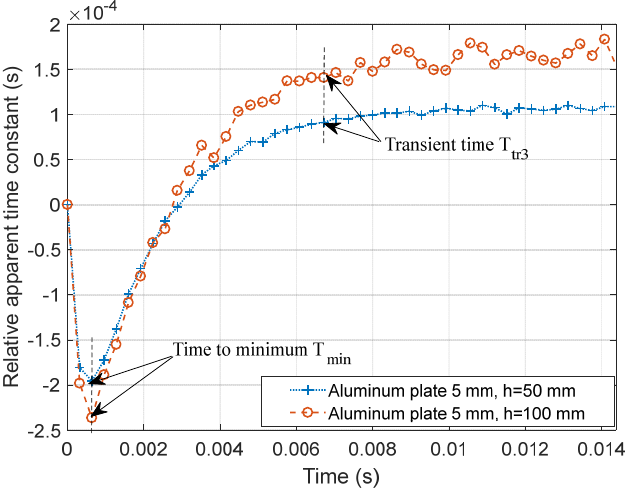
Figure 11. The effect of lift-off variations on the differential D-ATC curve. The increase in lift-off reduces the signal-to-noise ratio of the D-ATC curve but does not change the time characteristics. It can be seen from Figure 11 that the shortening of lift-off improves the signal-to- noise ratio of the D-ATC curve and compresses the amplitude of the differential D-ATC curve. However, lift-off variations did not change the time features (e.g., T min and T tr 3 ) of the differential D-ATC curve, which is consistent with the simulation result in Figure 4b. Therefore, the 𝑇 (cid:3047)(cid:3045) signature of the D-ATC curve is not affected by lift-off variations. This section further studies the characteristics of D-ATC on conductor thickness. The experimental results show that the 𝑇 (cid:3047)(cid:3045) and 𝜏 (cid:3002)(cid:3021)(cid:3004) (𝑇 (cid:3047)(cid:3045) ) signatures have sub-millimeter res- olution for thickness detection, and the 𝑇 (cid:3047)(cid:3045) signature is immune to lift-off variations.